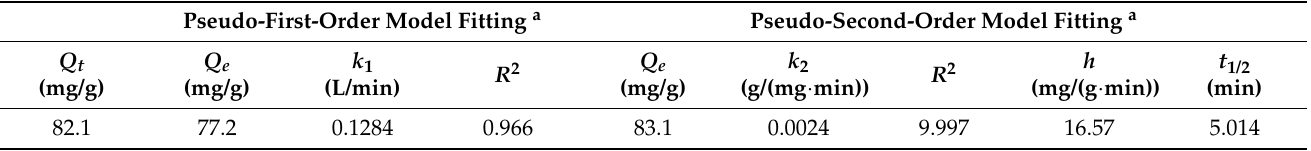
Table 1. Relevant parameters of micro-container kinetics